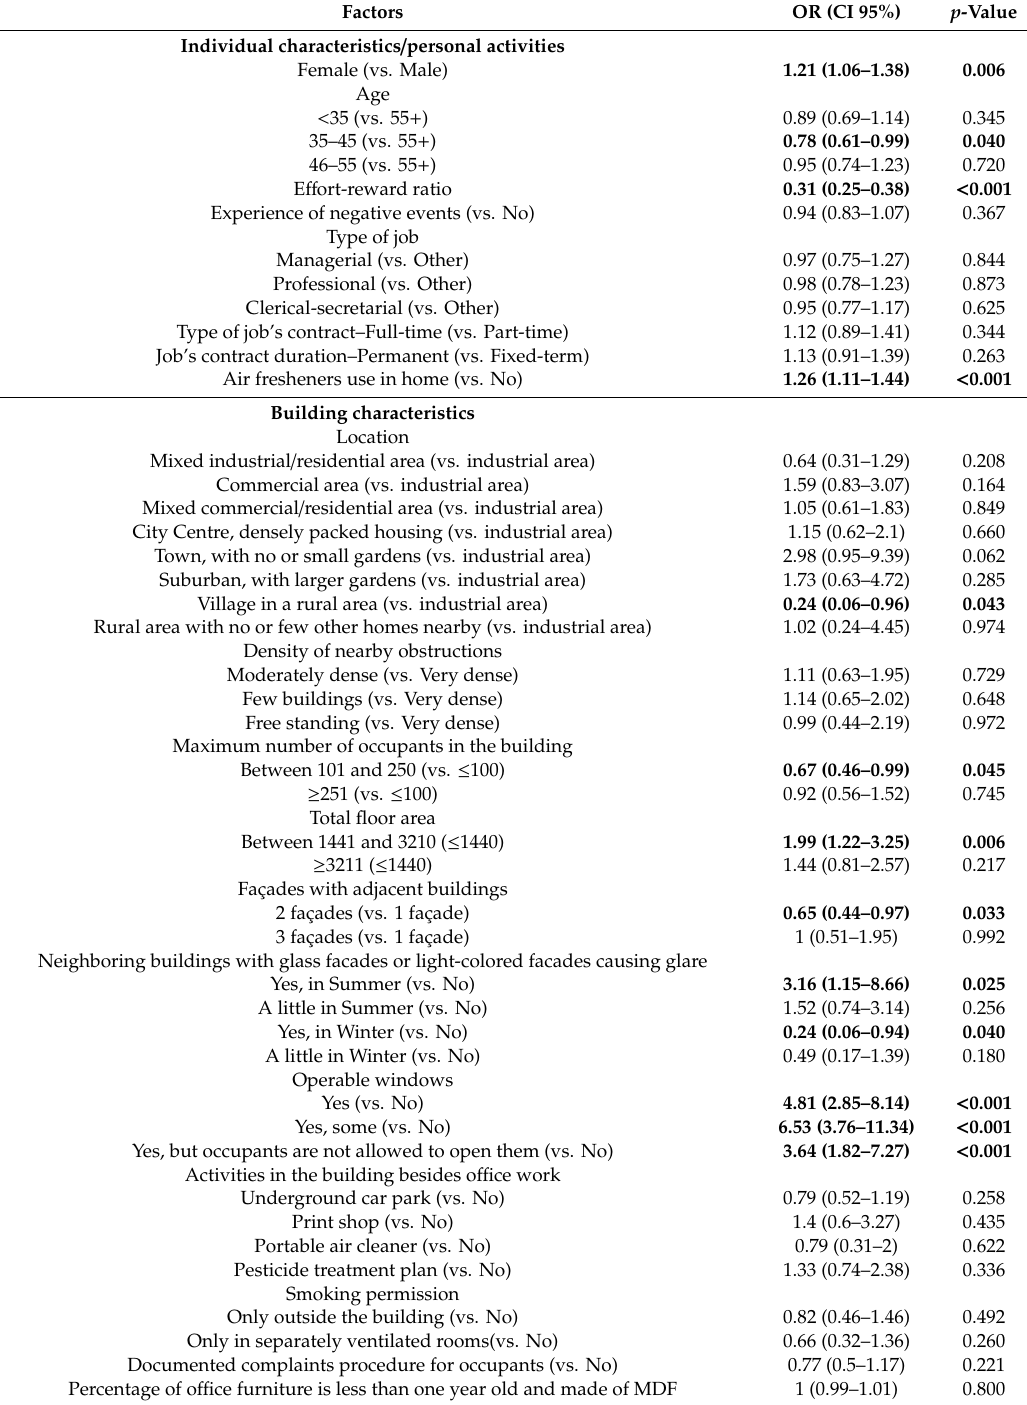
Table 5. Associations between combined overall perceived control, building characteristics and individual characteristics (Model